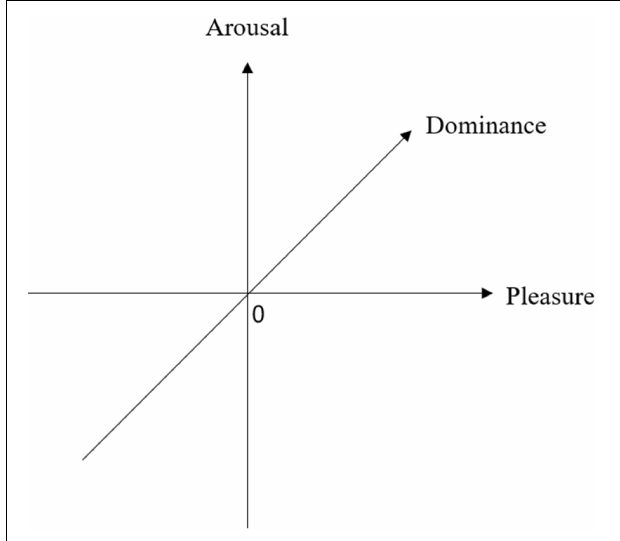
FIGURE 1 | The Pleasure-Arousal-Dominance (PAD) Emotion